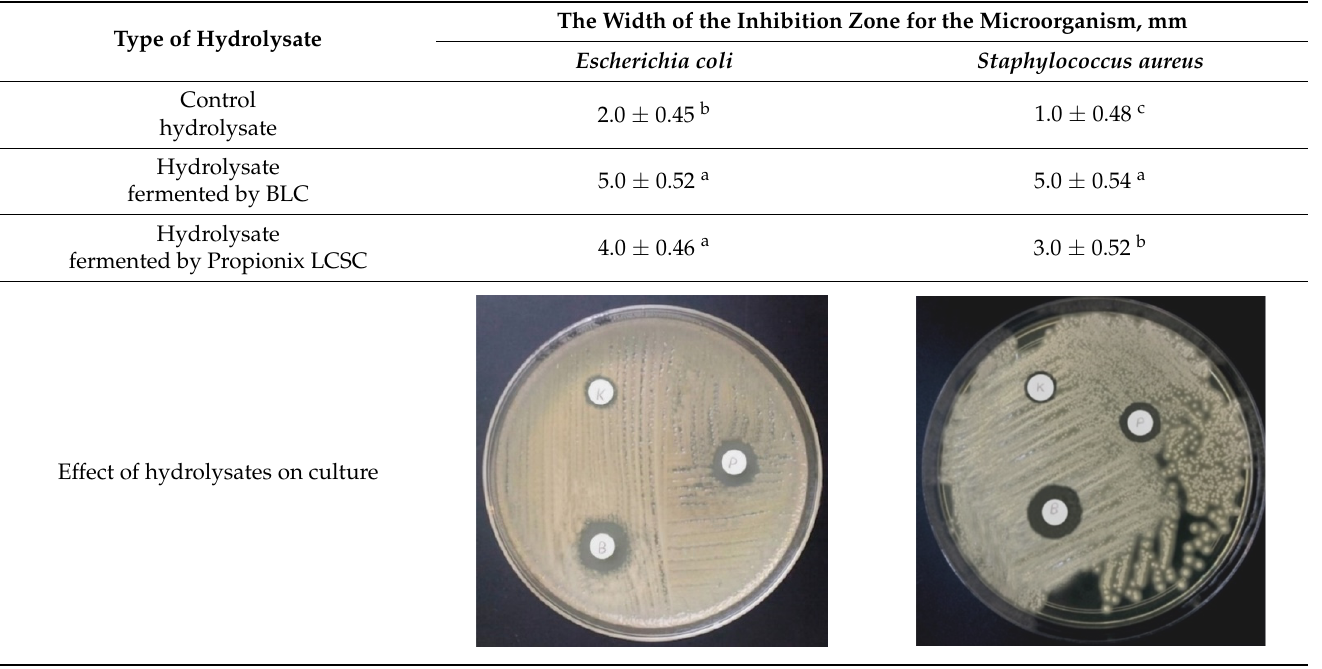
Table 4. The width of the inhibition zone of pathogenic microorganism’s growth.